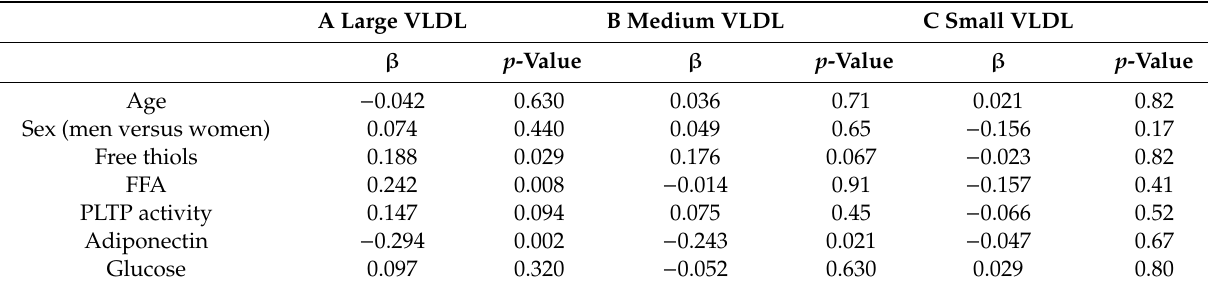
Table 5. Multivariable linear regression analysis demonstrating independent associations of very low density lipoprotein (VLDL) subfractions with age, sex, free thiols, free fatty acids, PLTP activity, adiponectin and glucose in 122 subjects (66 Type 2 diabetic subjects and 56 non-diabetic subjects). Panel A , Large VLDL; panel B , medium VLDL, panel C , small